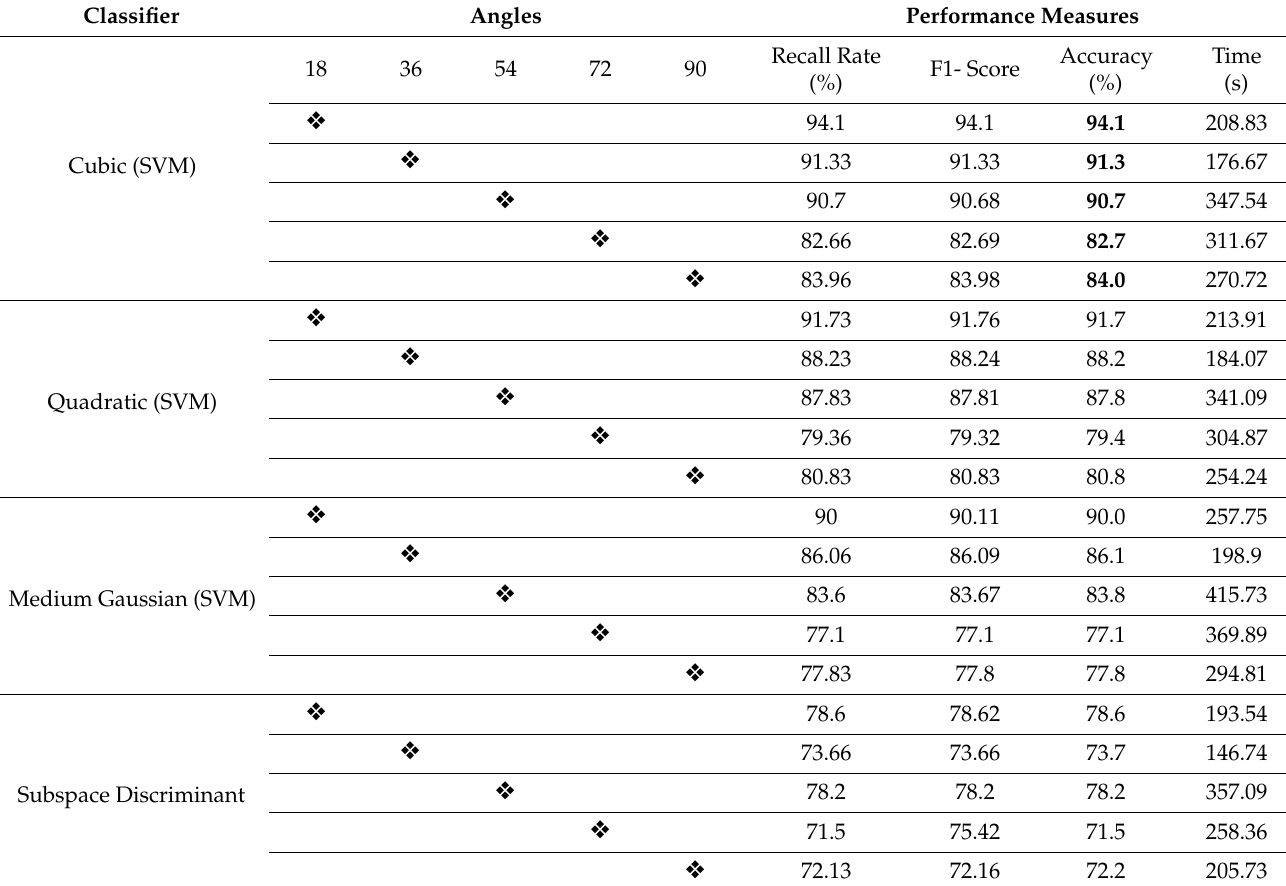
Table 3. Gait recognition results using modified NasNet-Mobile on selected angles of the non-augmented CASIA B da- taset.